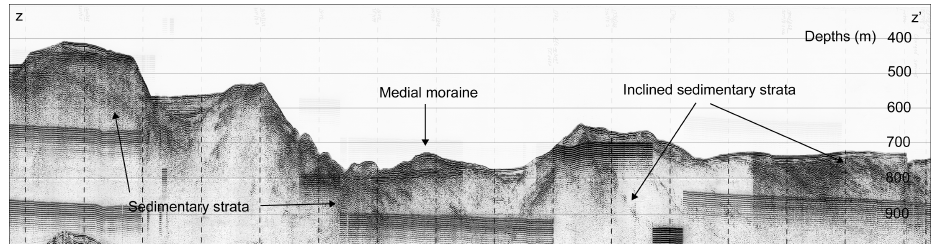
Figure 5. Air gun profile in Hecla & Griper Trough showing both sediment and bedrock ridges molded by glacial erosion (Profile 78029_AG_268_0110; NRCan). The profile also shows inclined sedimentary strata that were eroded by glacial